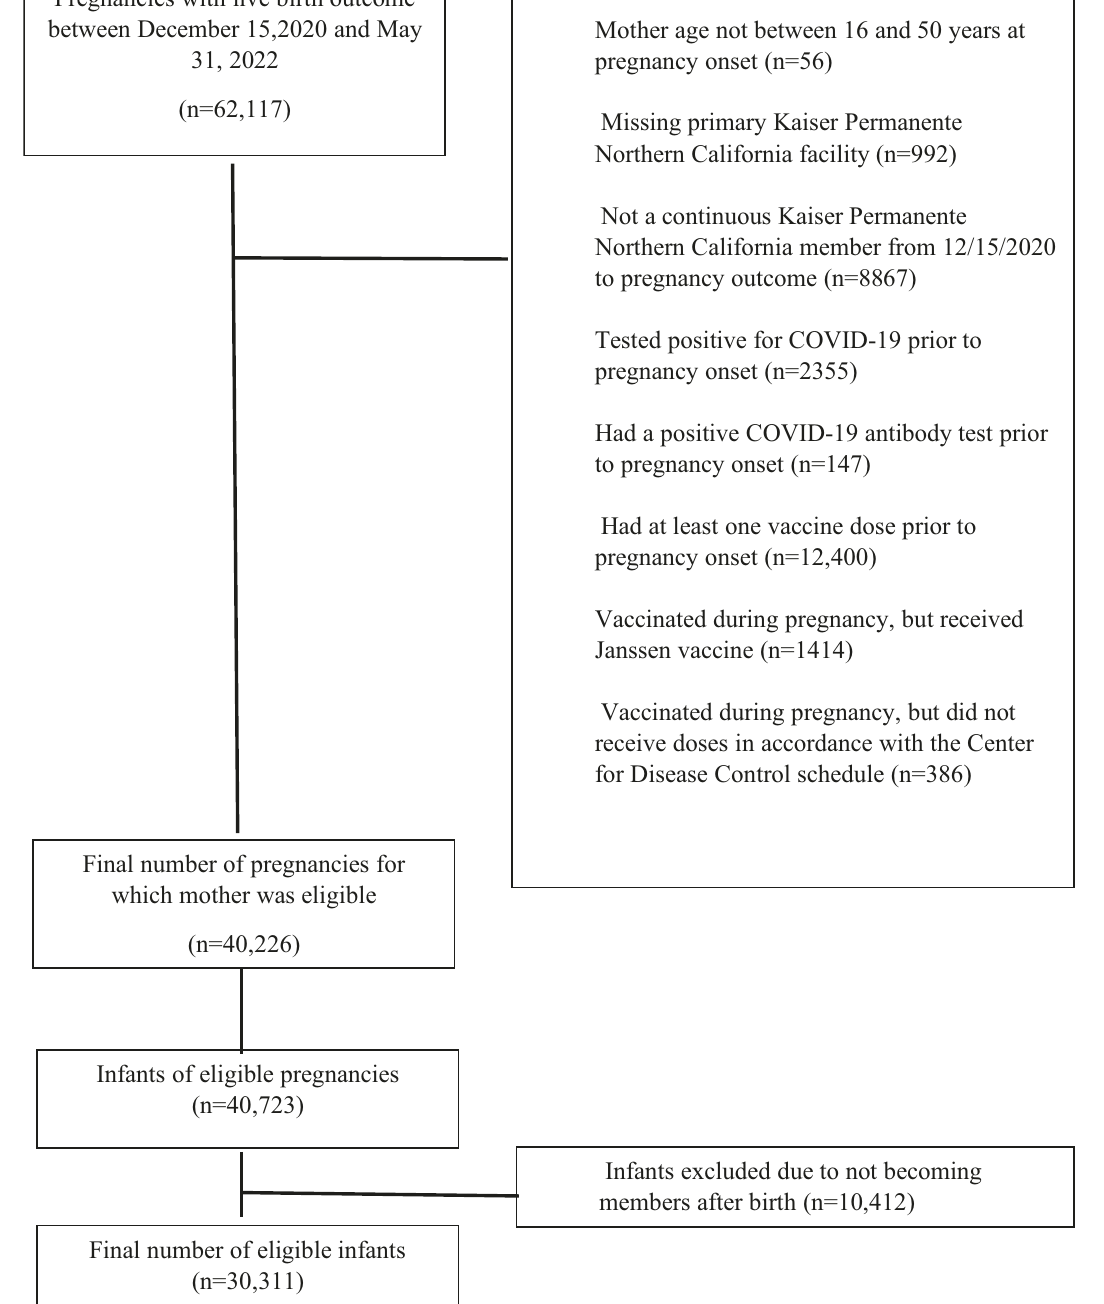
Fig. 1 | Construction of study cohort. Children born at Kaiser Permanente Northern California from December 15, 2020, through May 31, 2022.